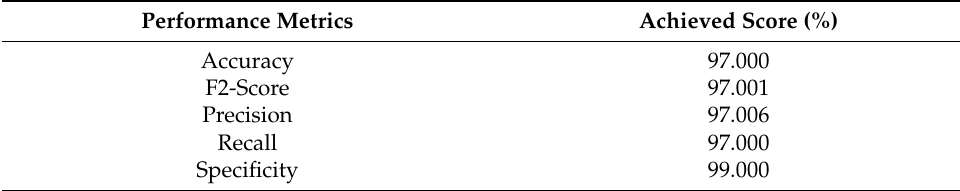
Table 9. Performance metrics of VGG19 for four-class